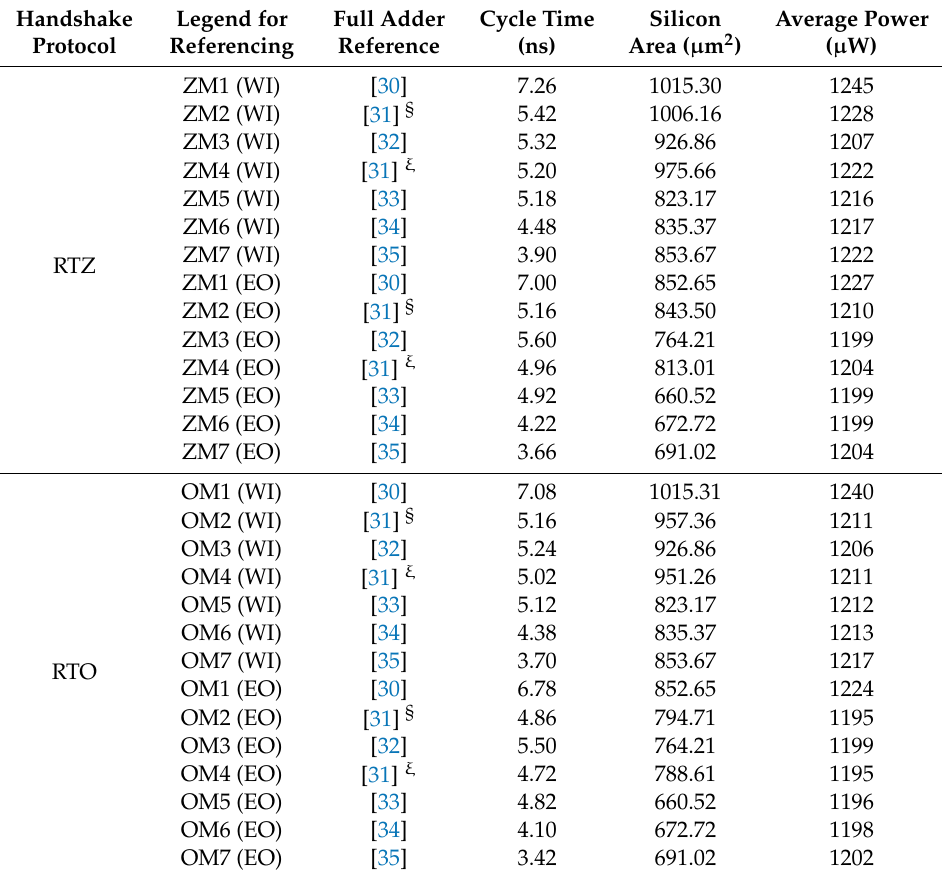
Table 1. Design metrics of QDI array multipliers corresponding to RTZ and RTO handshaking, realized using a 32 / 28 nm CMOS